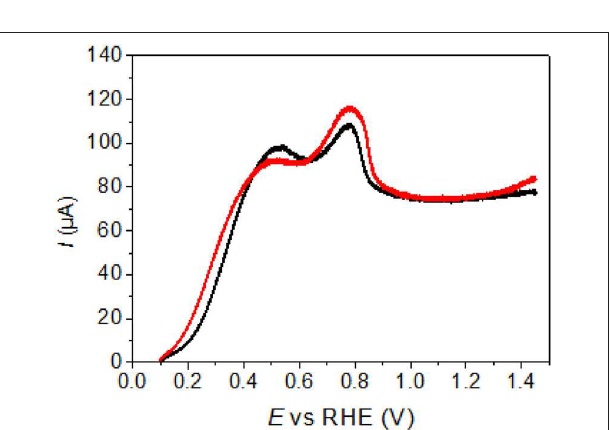
FIGURE 6 | Polarization curves recorded for the electrooxidation of glucose 10 − 1 mol L − 1 in NaOH 10 − 1 mol L − 1 aqueous electrolyte (T = 293K, scan rate = 5mV s − 1 ) on Au-modified Pd-NPs after dipping 1min in 1.00M HAuCl 4 solution. – for Pd-NS, – for Pd-NC and – for Pd-NO.